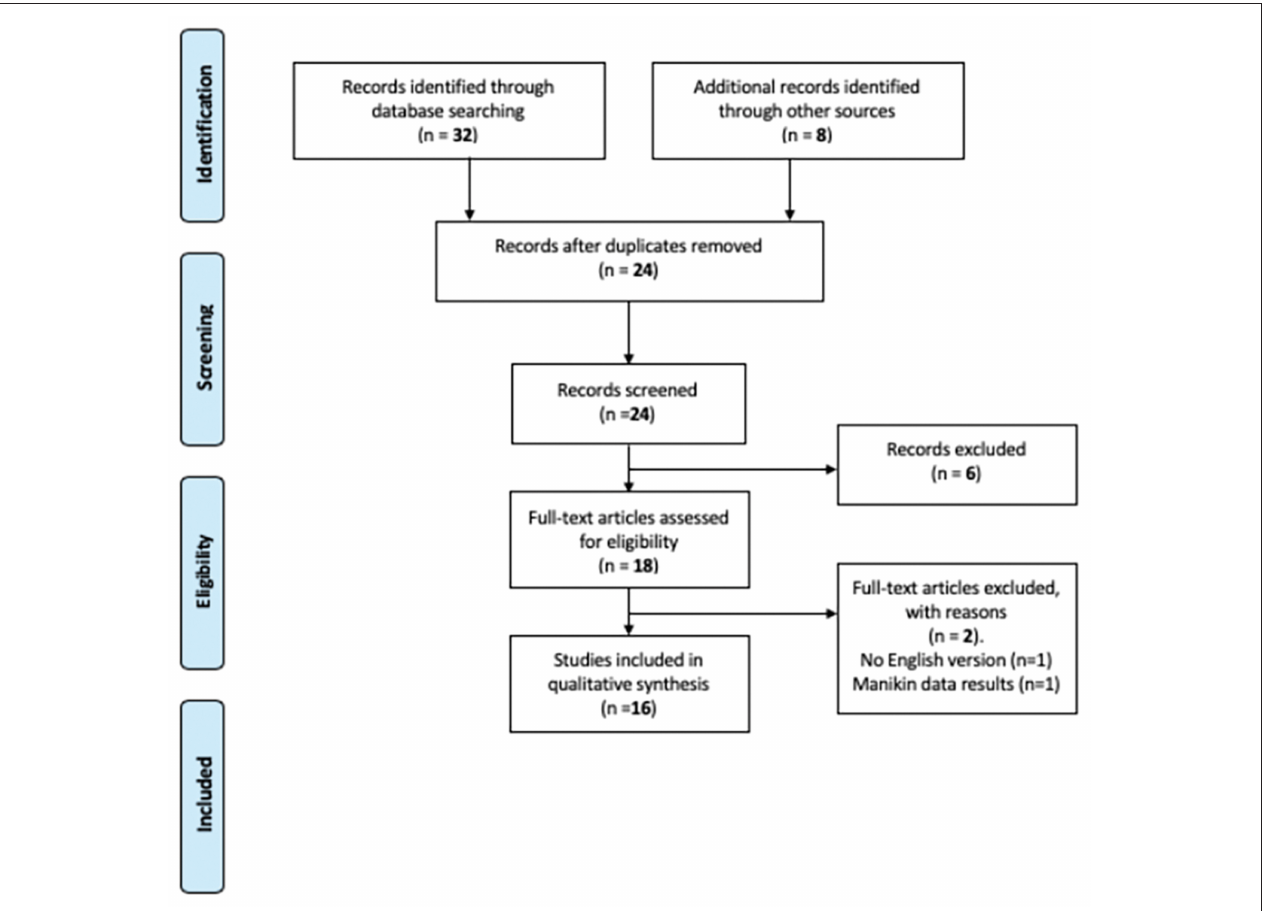
FIGURE 1 | Prisma 2009 flow diagram for TORS procedure performed in pediatric subjects.